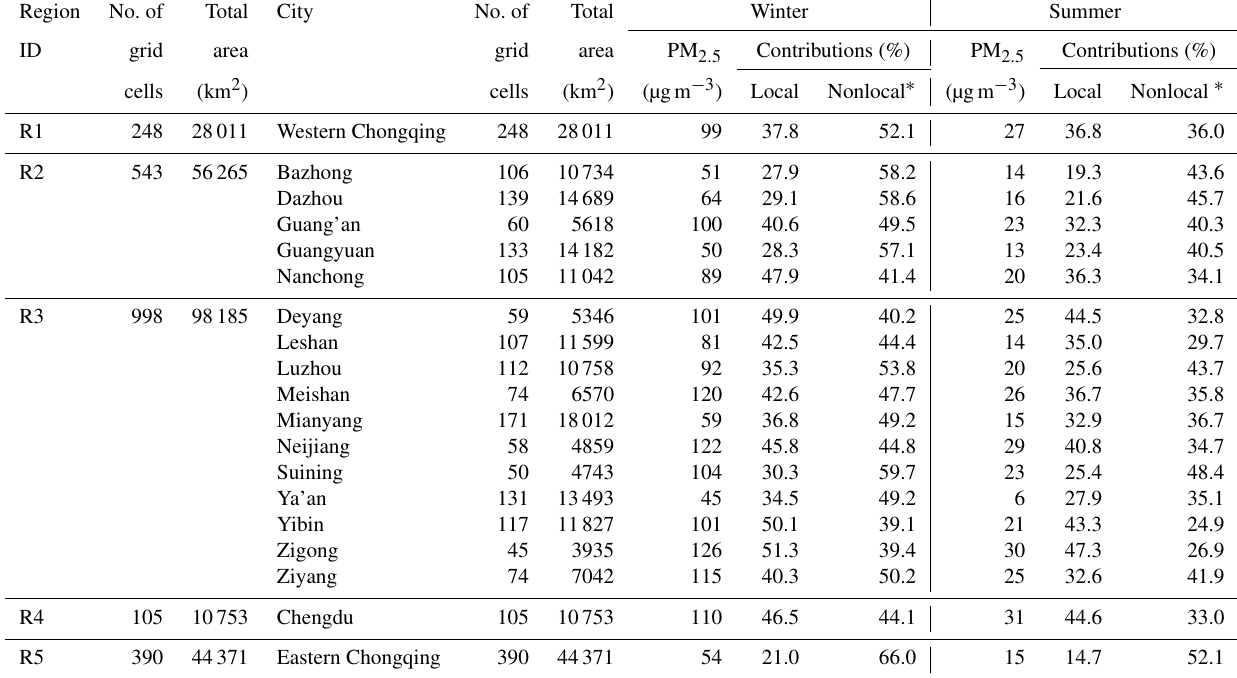
Table 2. Predicted citywide area-weighted average PM 2 . 5 concentrations and source-region contributions in the 18 SCB cities in the winter and summer.